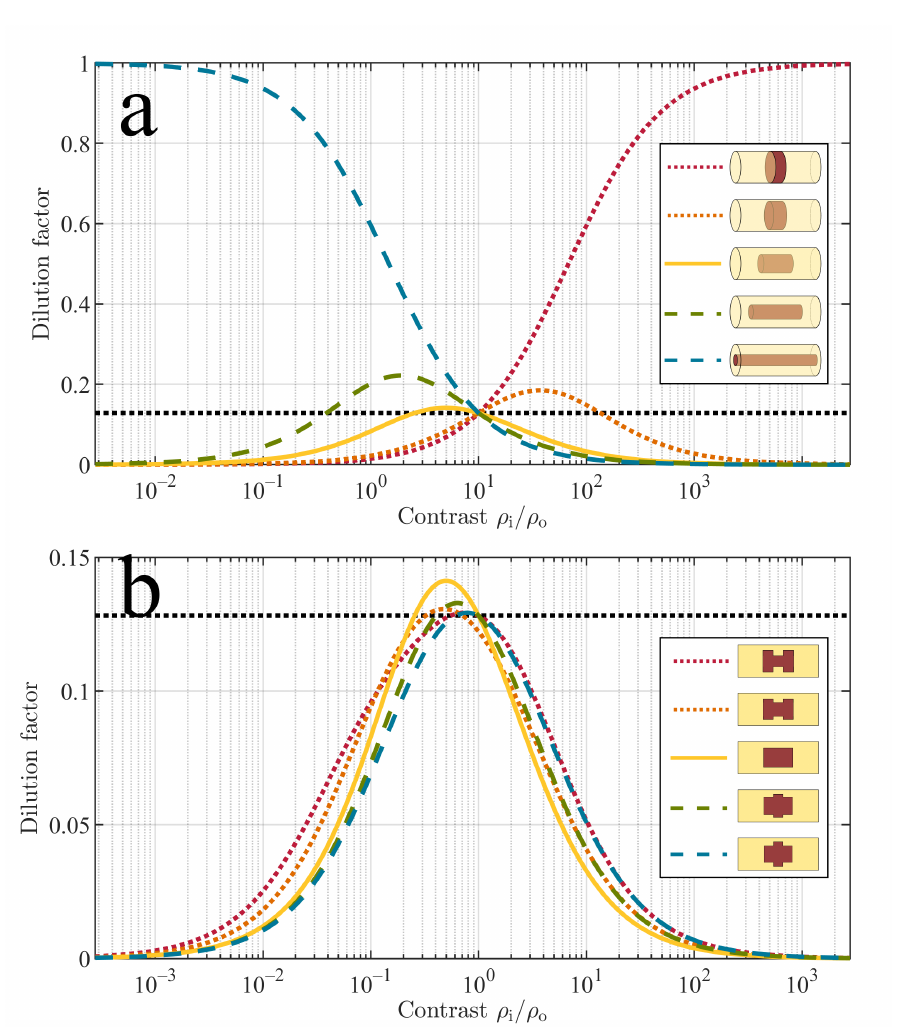
Figure 9. ( a ) Dilution factor obtained from numerical simulation vs. resistivity contrast between the inner and outer medium for cylindrical targets with varying elongation. The ratio r / l between the radius and length varies between 1.6 cm and 0.1 cm. ( b ) Dilution factor vs. resistivity contrast for targets with different shape. The volume is kept constant, whereas the radius of the middle section varies with r (cid:48) = { 0.7,0.9,1.3,1.5,1.6 } The length of the target changes such that the volume is kept constant at 19.6 cm 3